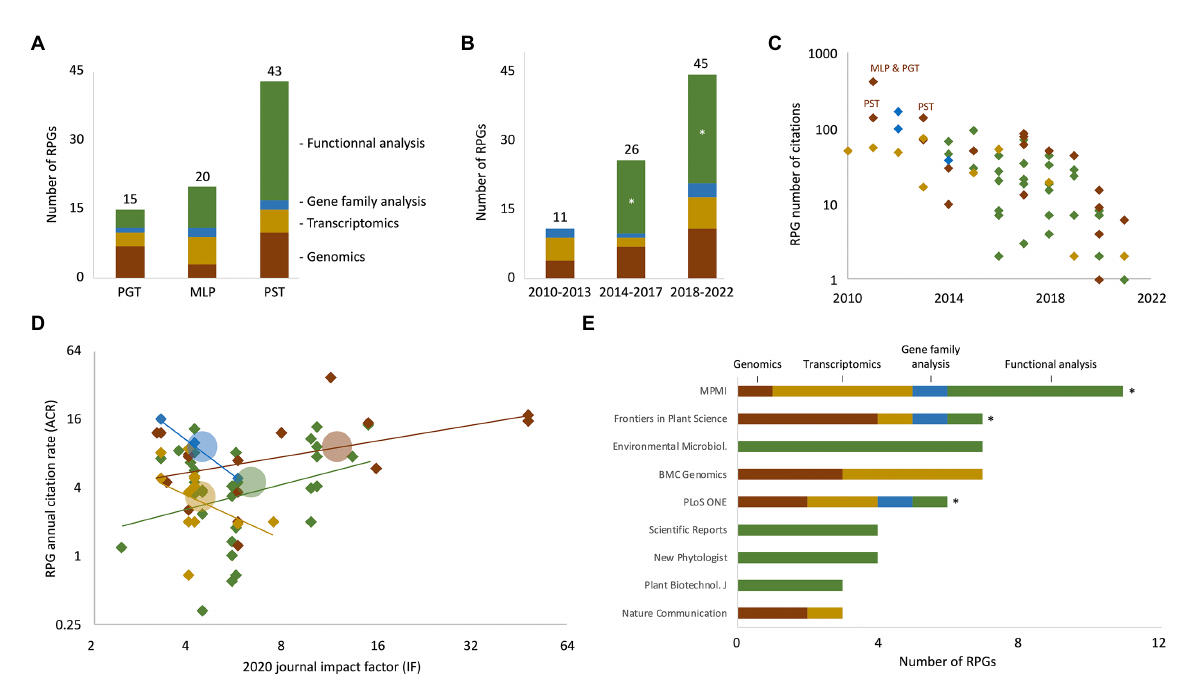
FIGURE 1 Overview of the 82 rust (post) genomic publications (RPGs) analyzed in this study. (A) Bar chart indicating the number of RPGs that primarily report genome analyses (i.e., genomics; brown), transcript profiling analyses (i.e., transcriptomics; yellow), gene family analyses (blue), or functional analyses (green), and which address Puccinia graminis f. sp. tritici (PGT), Melampsora larici-populina (MLP), or Puccinia striiformis f. sp. tritici (PST). Numbers above each bar indicate the total number of RPGs for each species. The four RPGs that address a combination of P. graminis f. sp. tritici